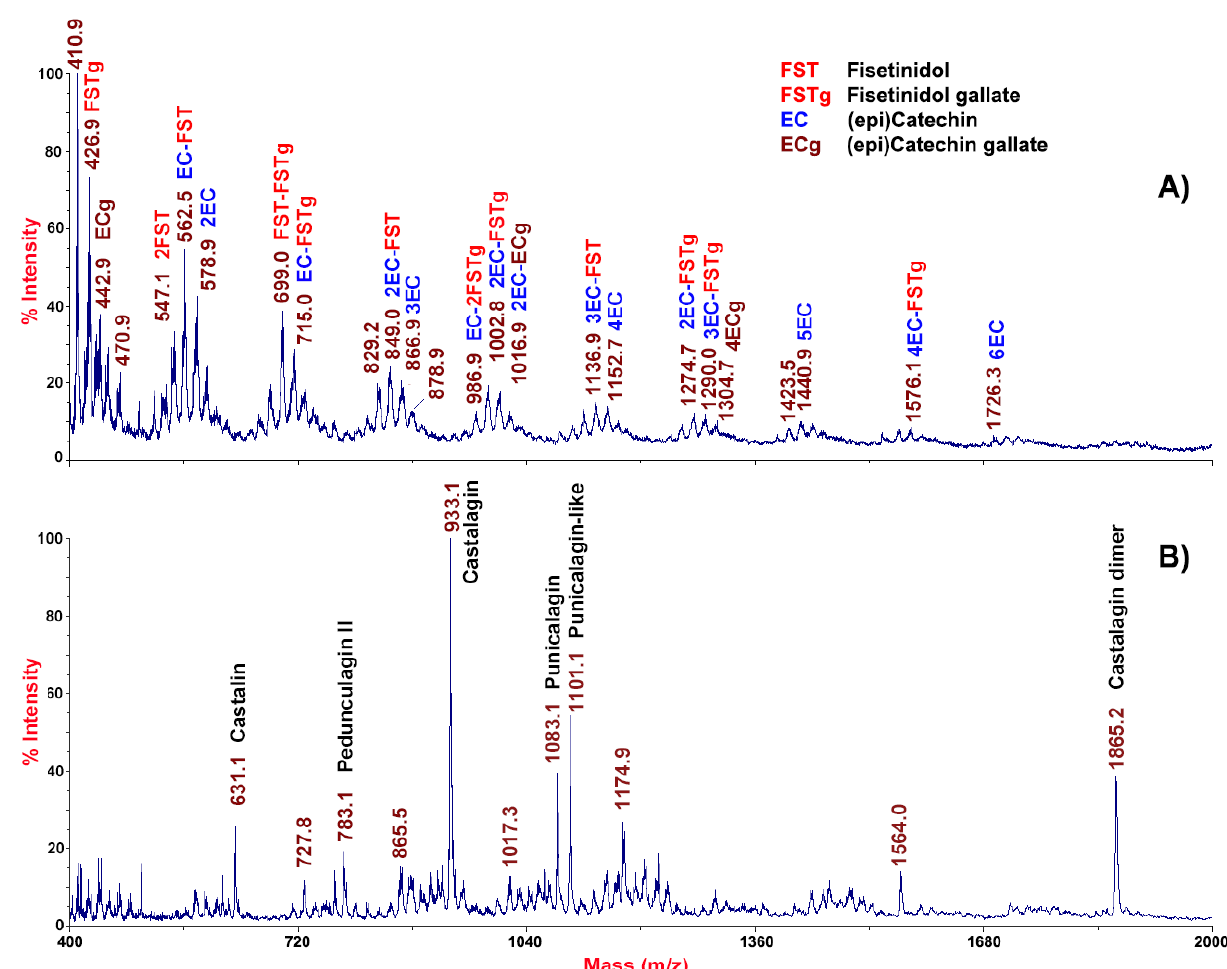
Figure 1. MALDI-TOF mass spectrum of the extract of chestnut pericarp tissues acquired in linear positive (panel ( A )) and negative (panel ( B )) ion mode. Condensed polymeric species were tentatively ascribed to gallotannins and ellagitannis derivatives. FST, fisetinidol; FSTg, fisetinidol gallate; EC, (epi)catechin; ECg, (epi)catechin gallate; g, gallic acid.